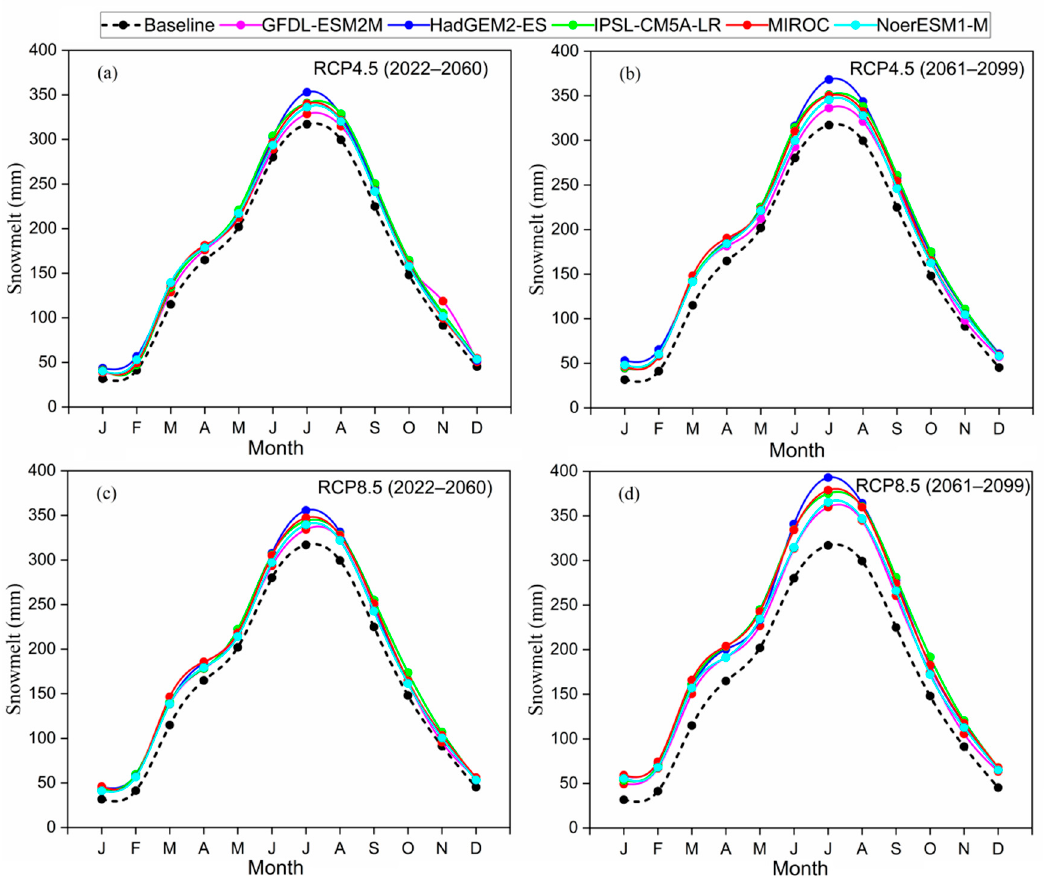
Figure 11. The projected monthly snowmelt during the 2022–2060 and 2061–2099 periods for the five GCMs under ( a,b ) RCP4.5 and ( c,d ) RCP8.5 in the Vakhsh River Basin, Central Asia.